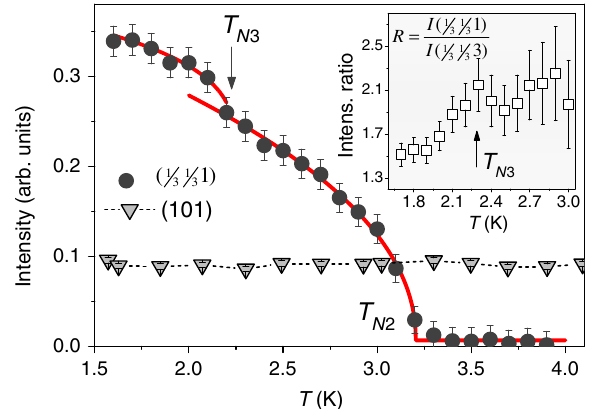
FIG. 9. Temperature dependence of ( 1 , 1 , 1) magnetic peak 3 3 intensity revealing the long-range magnetic order of Mn2 ions on ≈ 3 . 2 K followed by a spin reorienta- the triangular layer at T N 2 ≈ 2 . 2 K. The absence of magnetic scattering con- tion at T N 3 tribution to the (1,0,1) reflection across the two low-temperature transitions suggests that the intermediate magnetic order consists of a collinear up-up-down structure with modulated amplitude (see text for details). The inset displays the temperature depend- ence of the ratio of the intensities ( 1 , 1 , 1) and ( 1 , 1 , 3). The larger 3 3 3 3 gain in intensity of ( 1 , 1 , 3) below T demonstrates that magnetic 3 3 N 3 moments are rotating away from the c axis to produce a Y -type spin